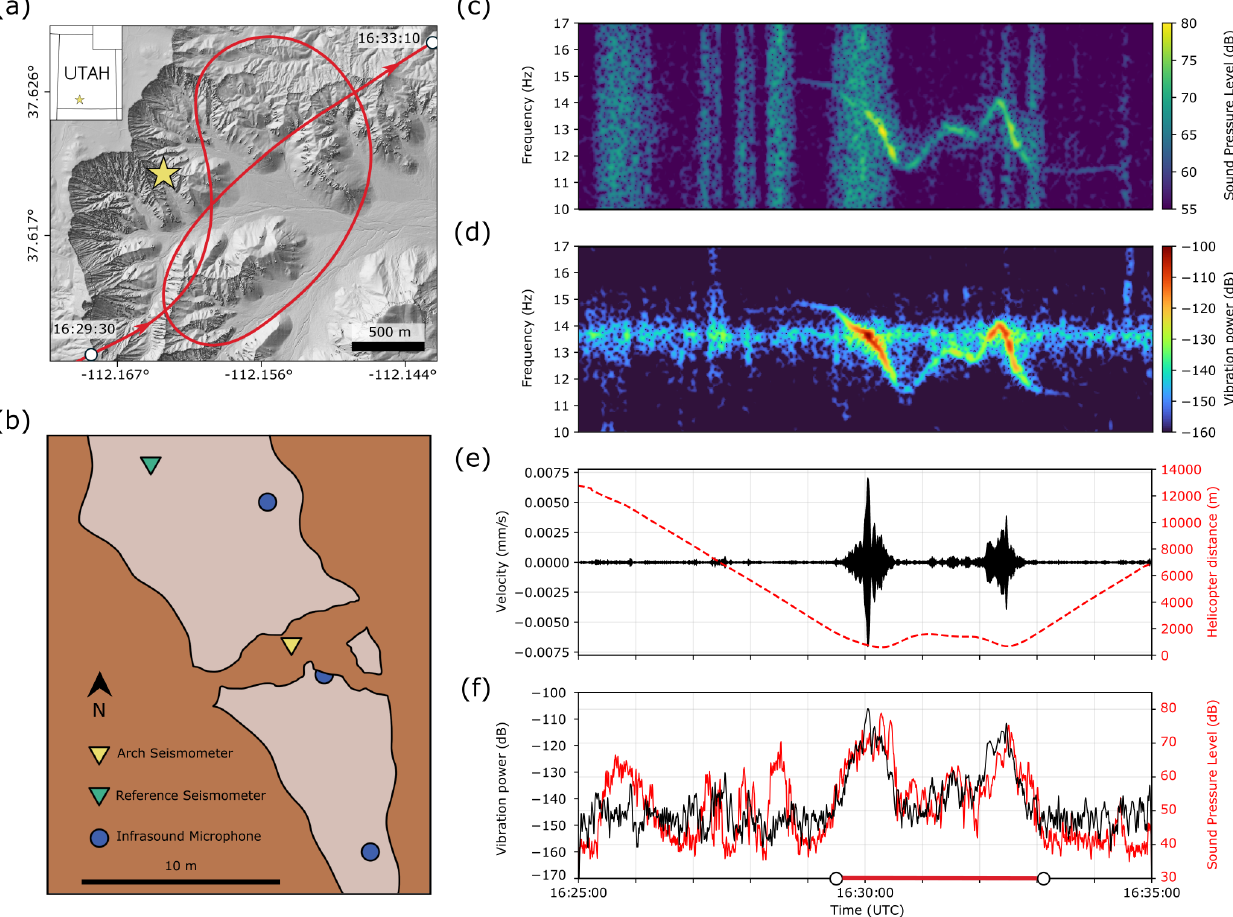
Figure 2. (a) GPS track of the tourist helicopter flight over Bryce Canyon National Park: the helicopter arrives from the south; Two Bridge location is indicated by the yellow star. (b) Overhead schematic of field equipment layout. (c) Infrasound sound pressure level spectrogram. (d) Two Bridge vibration velocity spectrogram. (e) Two Bridge vibration velocity (black) and helicopter distance from the bridge (red) over time. (f) Arch vibration power (black) and infrasound sound pressure level (red). White circles on lower axis correspond to start and end times of the helicopter’s flyover in (a) . Decibel amplitudes in (c) and (f) are relative to 20 × 10 − 6 PaHz − 1 for sound pressure level, while decibel powers in (d) and (f) are relative to 1m 2 s − 2 Hz − 1 for vibration power.